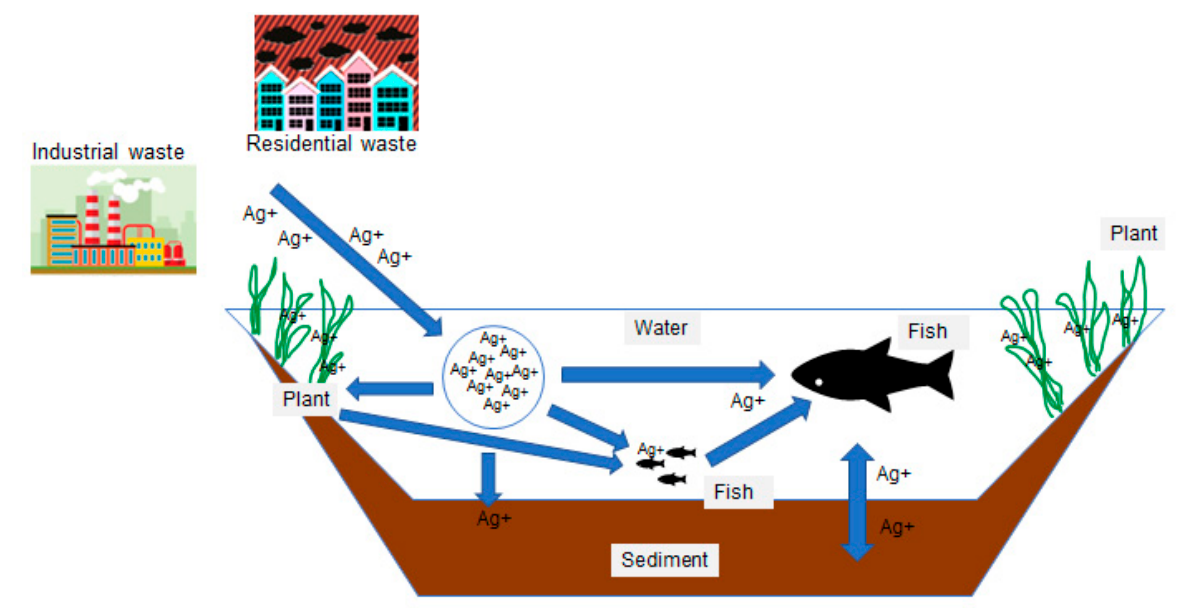
Figure 8. Trophic transfer of Ag through the aquatic food web.